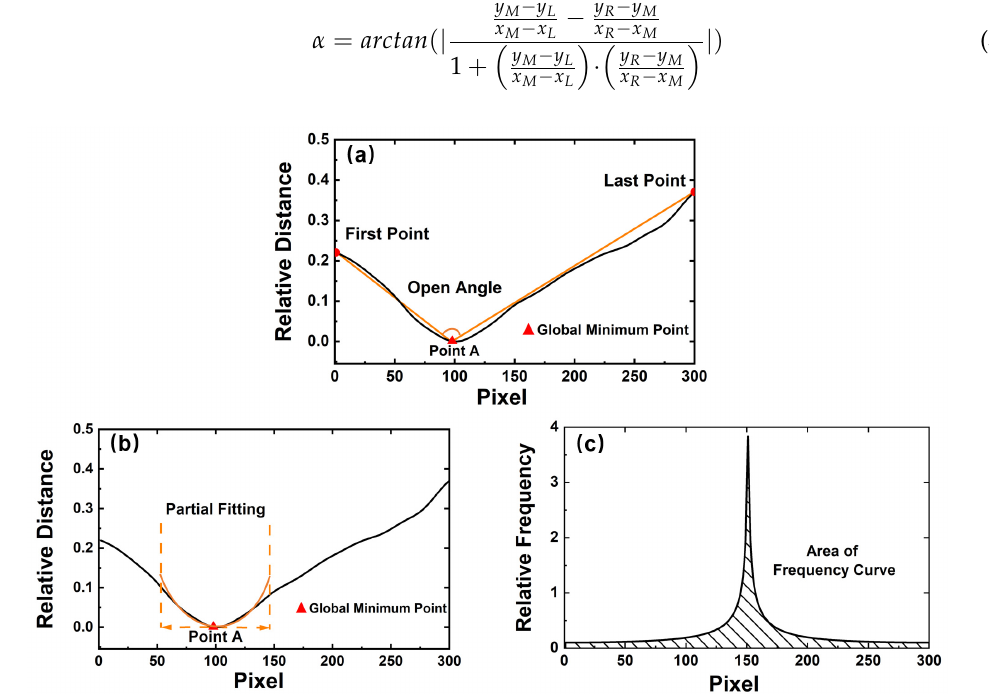
Figure 6. Three features of N95 mask: ( a ) opening angle of the contour curve, ( b ) quadratic coefficient of the partial fitting curve, and ( c ) area of the frequency curve from the Fourier transform of the spatial contour curve.